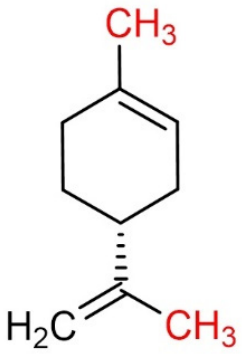
Figure 3. Alyl carbons in the structure of limonene.